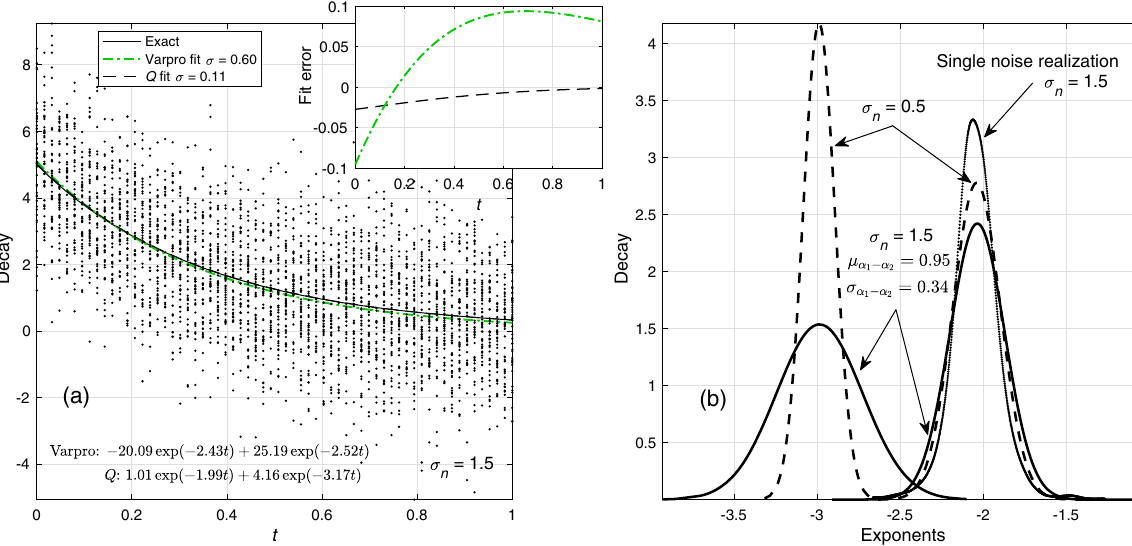
FIG. 11. Nonlinear regression for the two-species radioactive decay. (a) Data are the sum of two decaying exponentials buried in Gaussian white noise with σ ¼ 3 = 2 . Also shown are Q and V arpro fits and the true signal. The indicated standard errors for Q are relative to the exact answer, and on this basis, the Q regression is 5 times more accurate. But the deeper problem is revealed by the detailed form of the regression for this realization (bottom), where the V arpro result gives two nearly equal exponents and large coefficients of opposing signs, while Q matches all four parameters well. (b) The pdfs for each Q fit exponent from 2500 realizations, solid black line for noise with σ ¼ 3 = 2 and dashed line for σ ¼ 1 = 2 . The dotted curve shows the pdf for repeated independent minimizations of a single realization, a consequence of the imbricated surface seen in the next